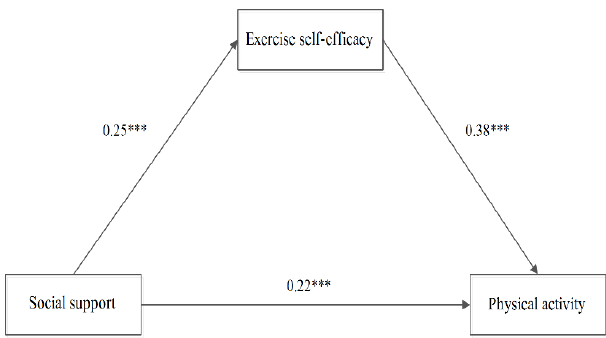
Figure 2. The mediating effect of exercise self-efficacy in boys. (Notes: *** means p > 0.001.)